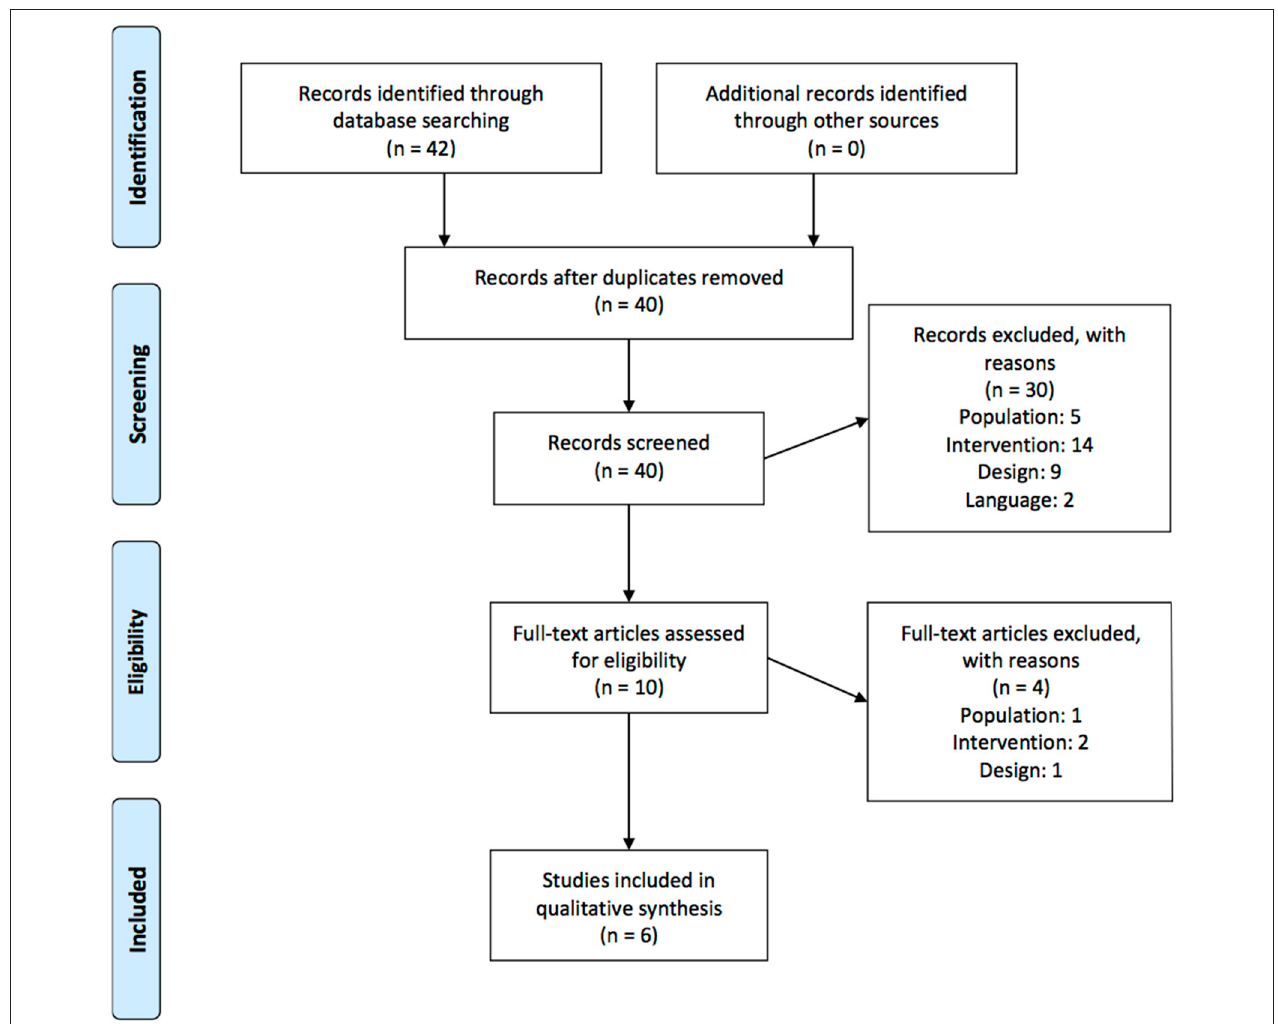
FIGURE 1 | Flowchart of study selection